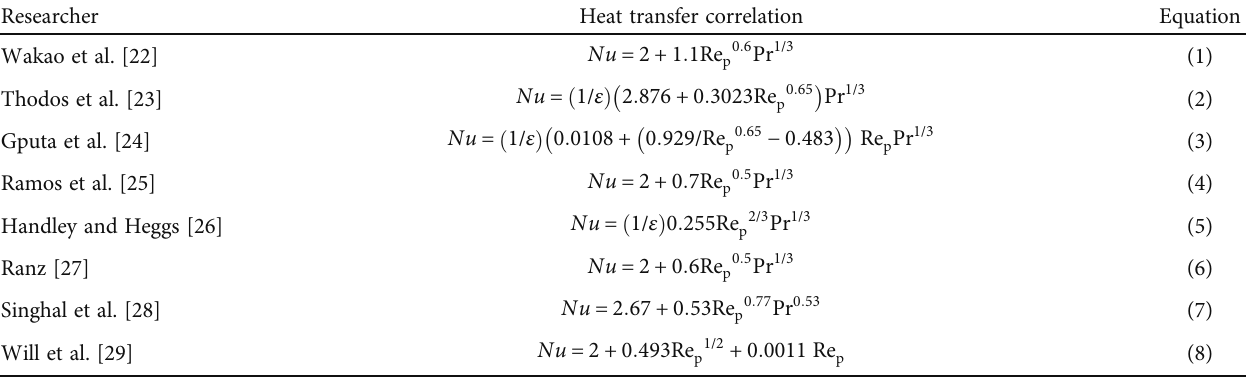
Table 1: Summary of previous correlations in the Nusselt number form for the gas-solid heat transfer in the particle packed bed.